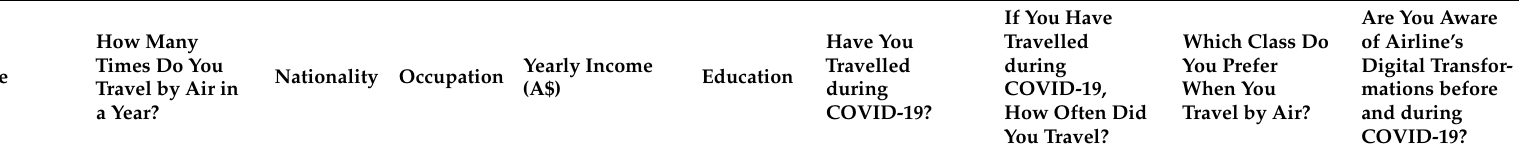
Table A5. Correlation analysis of demographic